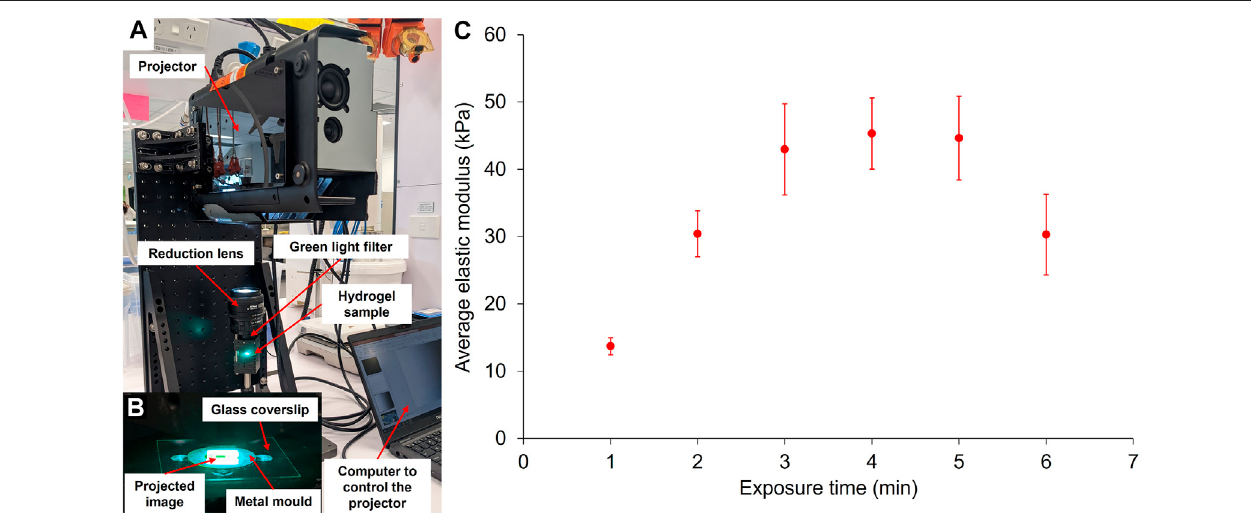
FIGURE 5 | Crosslinking of GelMA via the projector system (A) . With this system, a digital image is directly projected at the surface of the pre-gel solution to create patternsofstiffnessintheGelMA (B) .Theresultingelasticmodulusof10 wt%GelMAhydrogelsaccordingtotheirexposuretimeundertheprojectorhasbeenmeasured by force indentation measurements with AFM (C) (errors bars: standard error over fi ve force maps per exposure time).